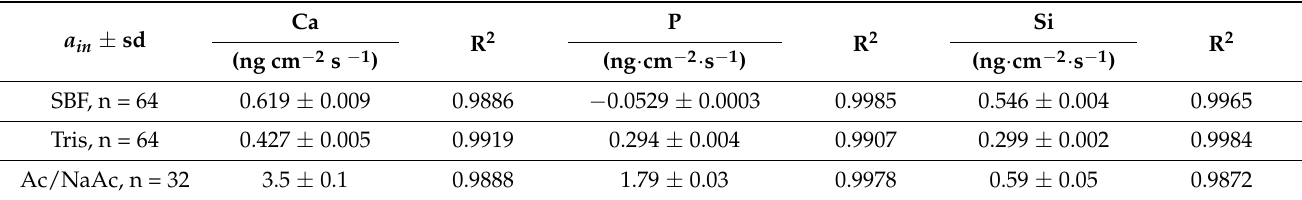
Table 3. Parameters for estimating the initial ion release rates ( a in ) obtained from fitting the inline ICP data via linear regression nl i = f(t) in an interval from 2 to 15 min as determined for all tested solutions. a in ± sd